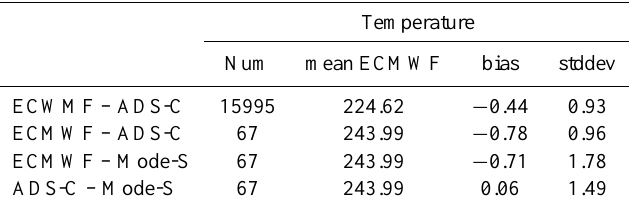
Table 3. Statistics of the comparison of temperature observations from ADS-C versus ECMWF for the whole set, and triple comparison for ADS-C observations, Mode-S and ECMWF in the vicinity of Amsterdam Schiphol airport.